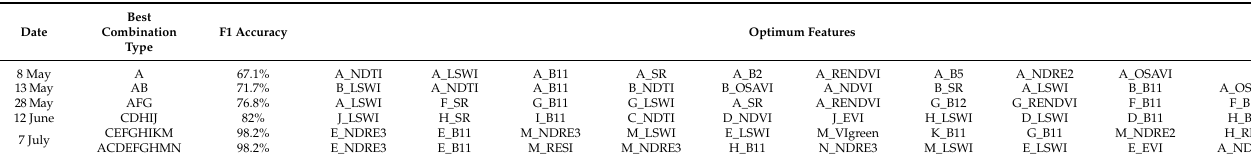
Table 11. The top-10 optimal feature set of best corn combination types for each period in 2020.